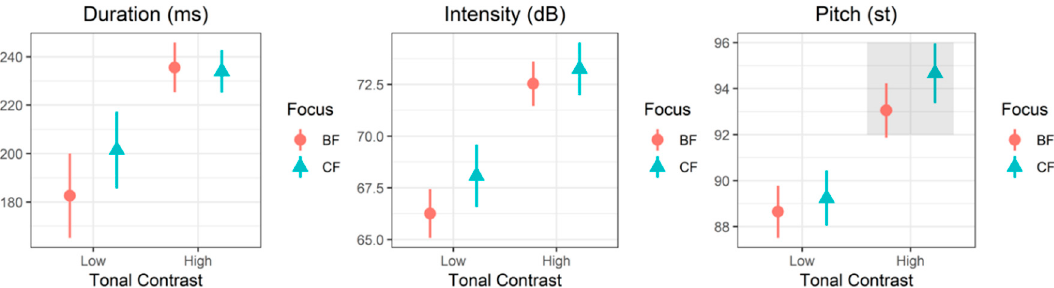
Figure 5. Duration, intensity, and pitch of each tone group in two focus conditions (BF: Broad focus, CF: Corrective focus; Low: Low tone group, High: High tone group). Points refer to mean values, and error bars indicate the 95% confidence interval.